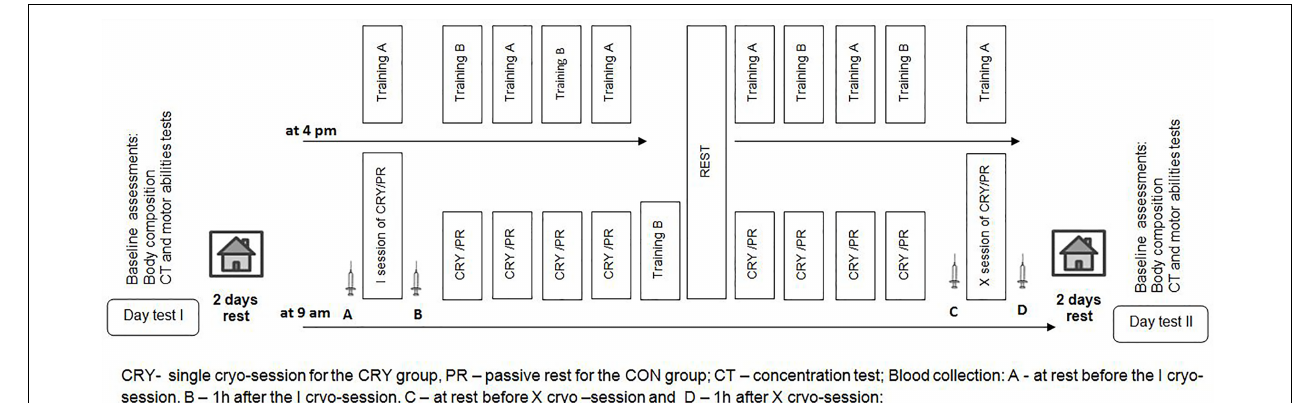
FIGURE 1 | Experiment